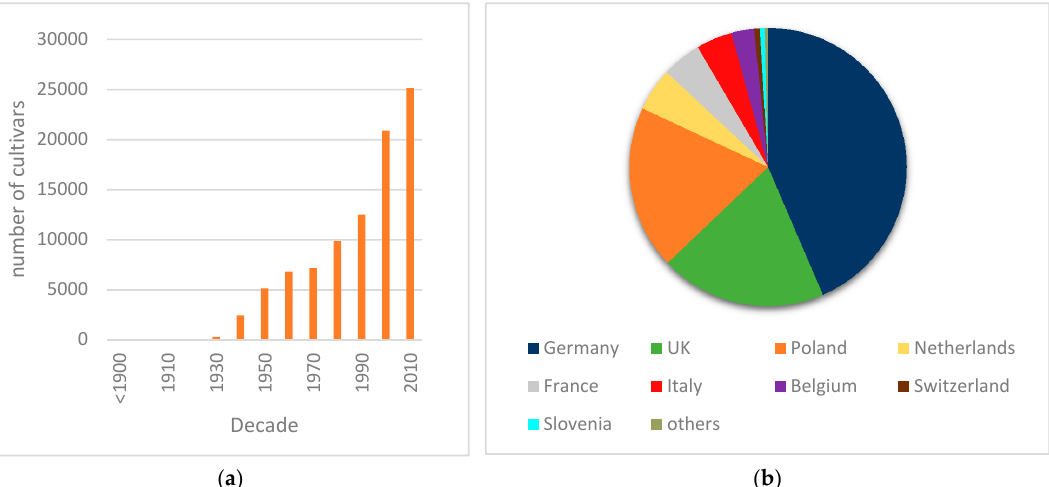
Figure 1. Registered daylily cultivars: ( a ) Number of daylily cultivars registered per decade according to the American Daylily Society database [5]; ( b ) proportion (%) of daylily cultivars registered in Europe per country (total = 2749; ‘others’ include Austria, Belarus and Czech Republic)